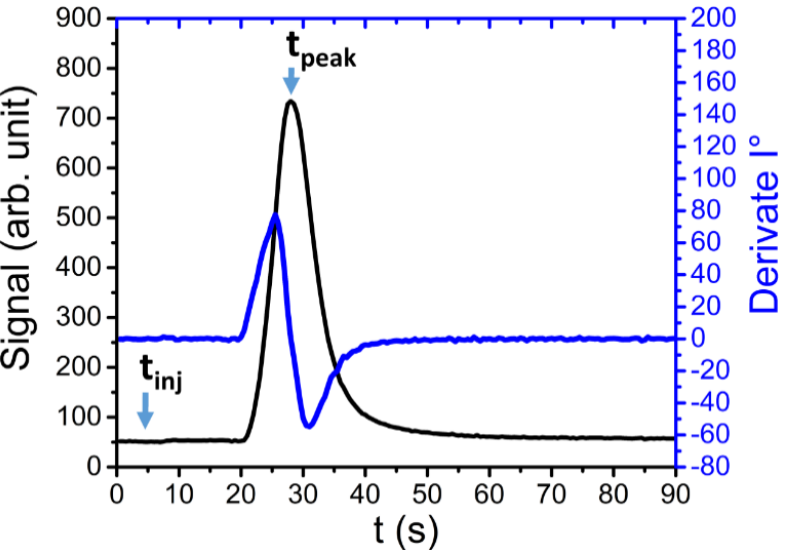
Figure 6. A detail of a benzene peak. In the Figure, t inj and t peak represent the injection and the peak instant, respectively. The peak Full Width at Half Maximum (FWHM) is about 8 s.